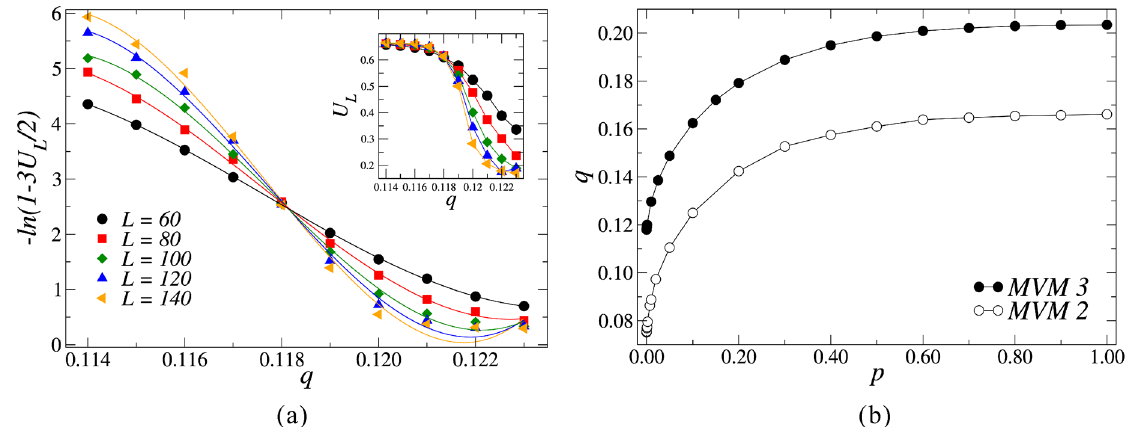
Figure 8. ( a ) Fourth-order Binder cumulant U L as a function of the noise parameter q for L = 60, 80, 100, 120 and 140. The lines are cubic polynomial fits to the data, yielding for p = 0.0001 a critical noise q c = 0.1181 ± 0.0002 . In the inset we show an overview for U L and the lines are guides for the eye. ( b ) Phase diagram of the three-state (two-state) majority-vote model in small-world networks (open symbols). The points represent the critical noise parameters q c as function of the rewiring probability p . The error bars are smaller than the symbols, and the lines are guides to the